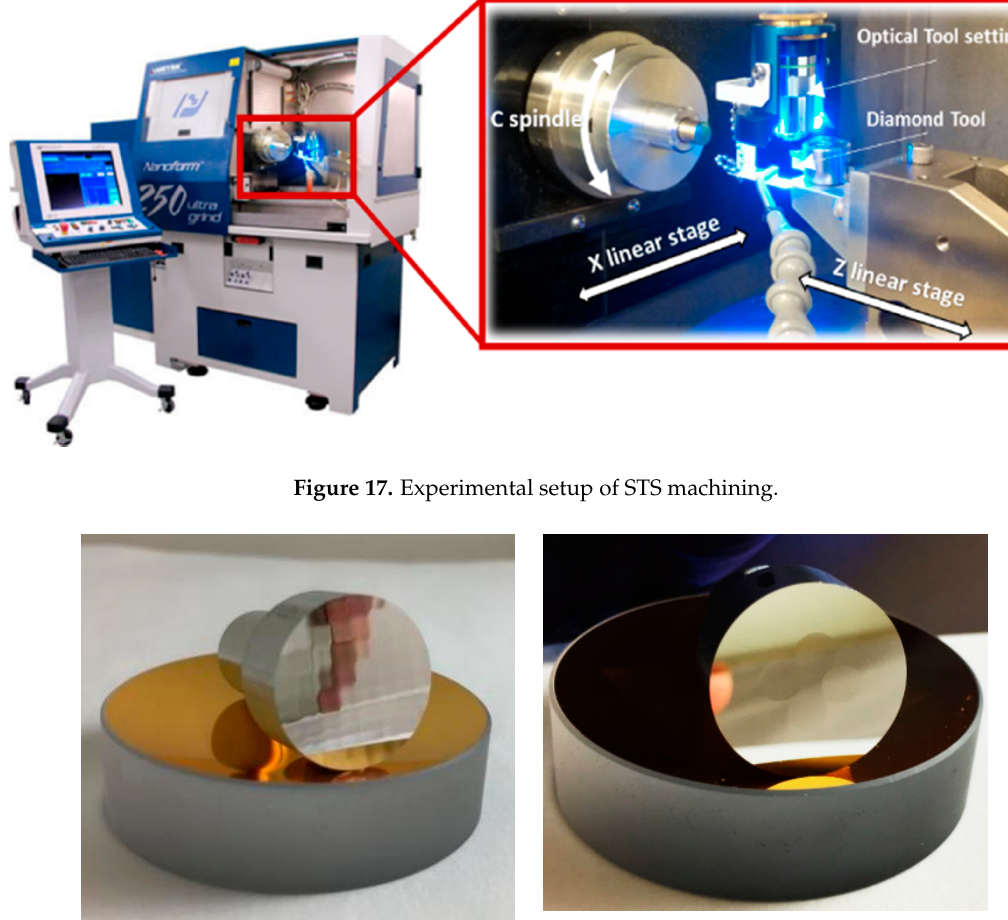
Figure 17. Experimental setup of STS machining.